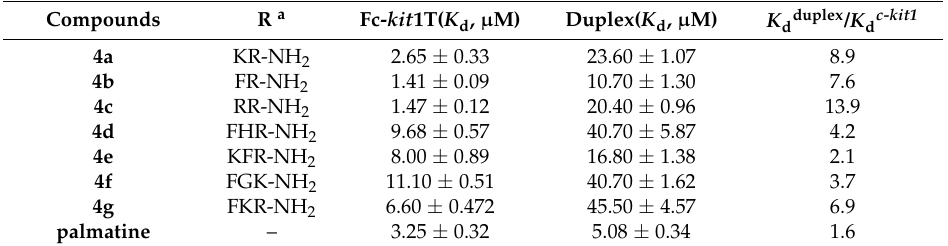
Table 5. Kinetic constants of palmatine derivatives with Fc- kit 1T and duplex DNA by microscale thermophoresis (MST)